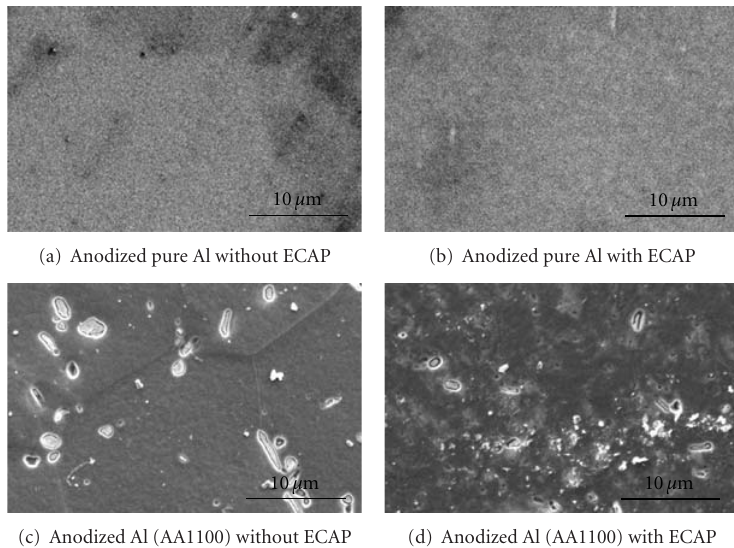
Figure 9: E ff ect of ECAP on the morphology of pure Al and Al (AA1100) anodized at 400 A · m − 2